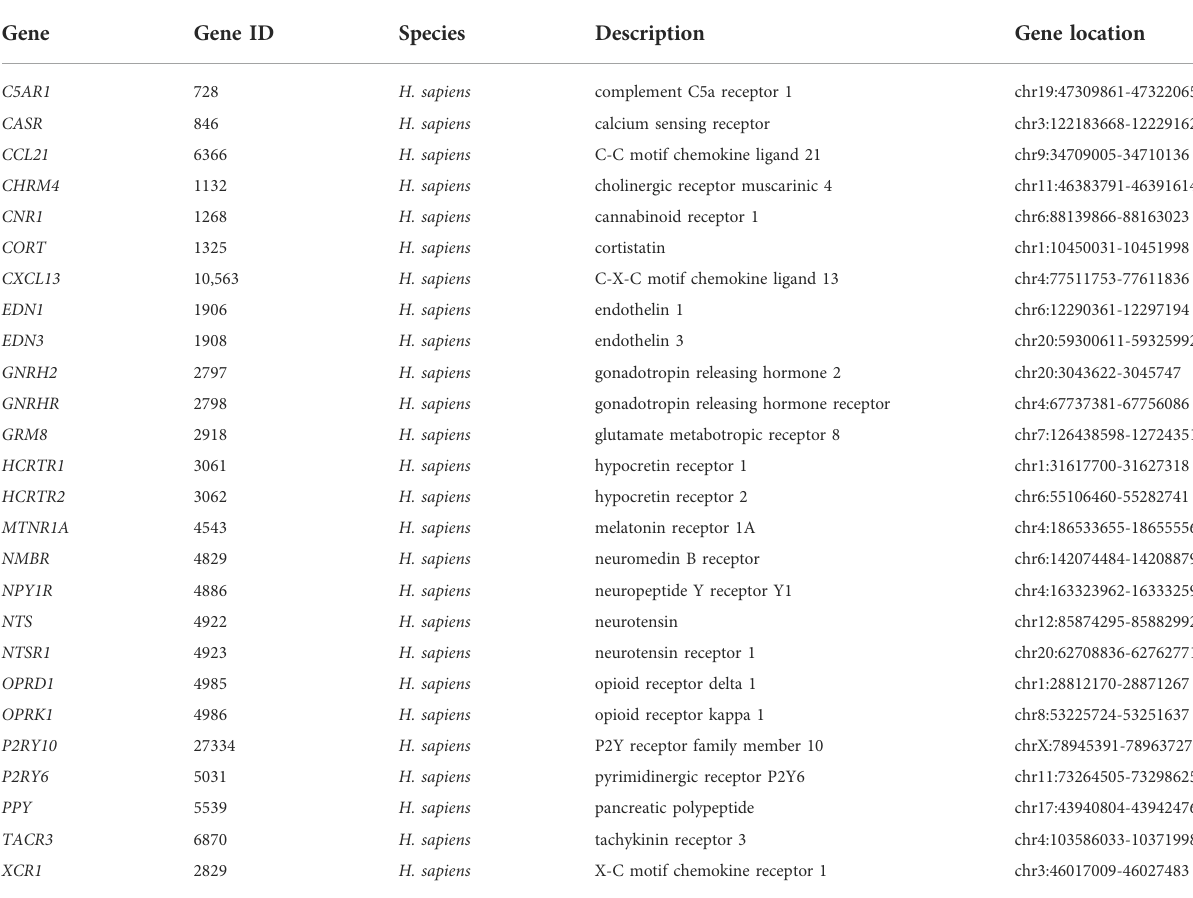
TABLE 3 Annotation of 26 key